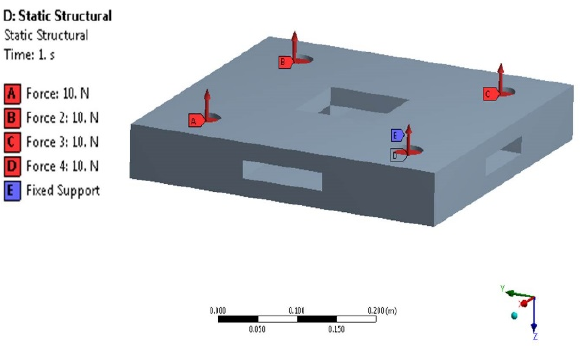
Figure 5. Description of load and supports.